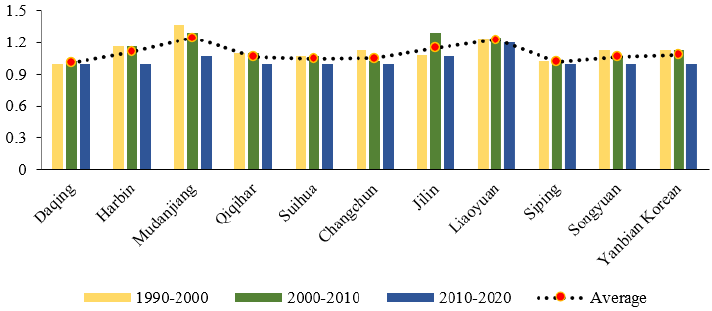
Figure 7. Changes in average path length in each city.